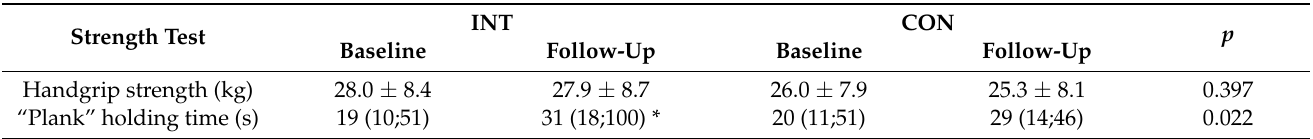
Table 2. Handgrip strength (mean ± SD, INT: intervention group, n = 24, CON: control group, n = 25) and “plank” holding time (median and quartiles, INT: n = 18, CON: n = 18) at baseline and follow-up (* significant within-group difference from baseline to